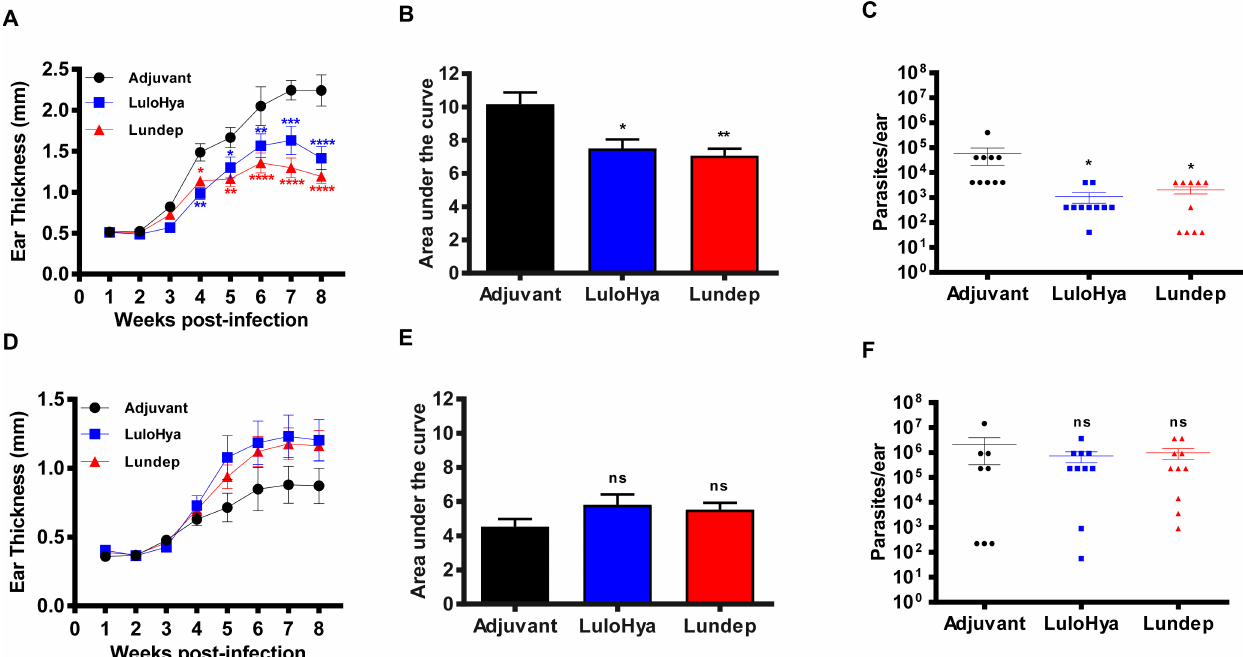
Fig 9. Vaccination studies with LuloHya and Lundep against L . major infection. (A) Lesion size of C57BL/6 mice due to L . major infection steadily increased from the second week of the follow-up period until it stabilized or started to decrease after week 7 in all animals. For control animals (only immunized with Magic Mouse Adjuvant) lesion size was higher than vaccinated groups from week 4 onwards. The symbols represent the lesion size mean of 10 ears ± SEM analyzed by analysis of variance. (B) Lesion size values of C57BL/6 mice were converted to the area under the curve (AUC) showing that mice immunized against either LuloHya and Lundep presented significantly reduced lesions. (C) Parasite load of ears from C57BL/6 mice vaccinated with LuloHya or Lundep was significantly lower than control group (P < 0.05). (D) L . major lesion size in B-cell-deficient B6.129S2- Ighm tm1Cgn /J mice. (E) There are no statistical significant differences in lesion size of B6.129S2- Ighm tm1Cgn /J mice immunized with either LuloHya, Lundep or adjuvant. (F) Parasite load of ears from B6.129S2- Ighm tm1Cgn /J mice vaccinated with LuloHya or Lundep showed no differences with the control group. Multiple comparisons were done by one-way ANOVA ( (cid:3)(cid:3)(cid:3)(cid:3) : p < 0.0001; (cid:3)(cid:3)(cid:3) : p < 0.001; (cid:3)(cid:3) : p < 0.01; (cid:3) : p < 0.05; ns: non-significant). Bars indicate SEM.